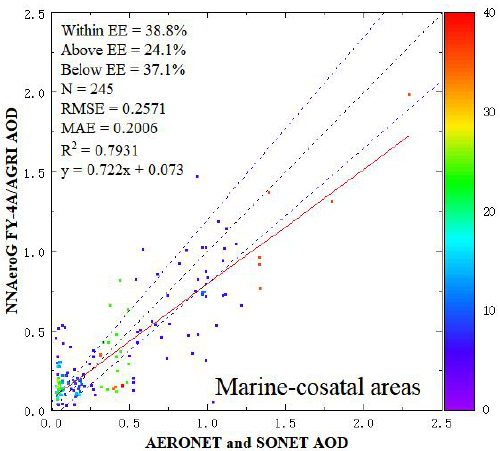
Figure 7. Scatterplots of the AOD retrieved using FY-4A/AGRI data over marine and coastal areas versus AERONET and SONET reference data. The blue lines are the EE envelopes for AOD of ± (0.05 + 15%). The red line is the linear fitting line of AOD. The black line represents the 1:1 line. The RMSE, MAE, R 2 and EE15 for the validation of the AOD retrieved over marine and coastal areas are 0.257, 0.201, 0.793 and 38.8%, respectively. The retrieval errors for